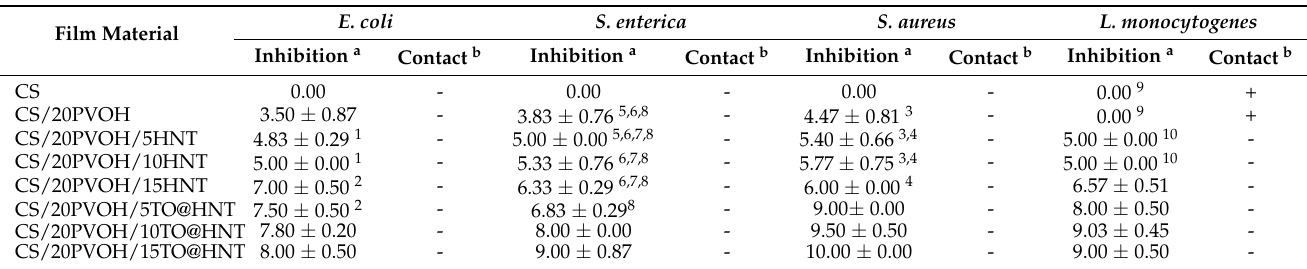
Table 4. Antibacterial activity of active films against food pathogenic bacteria E. coli , S. enterica , S. aureus , and L. monocytogenes